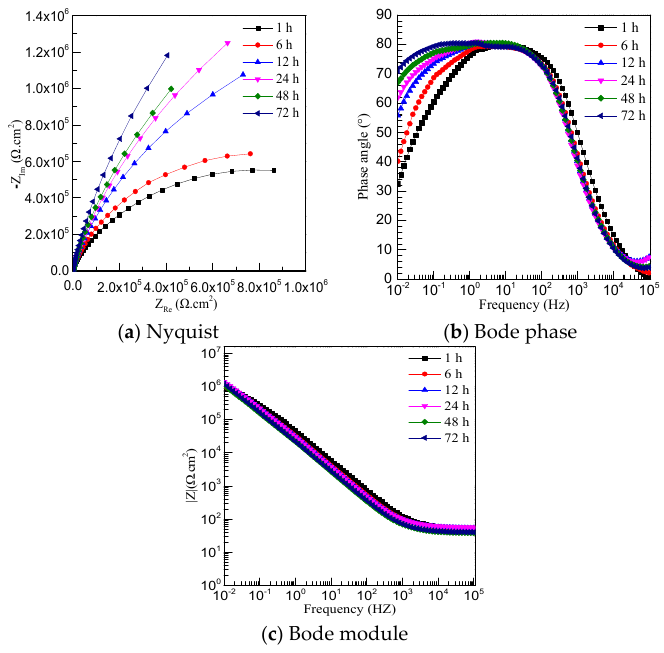
Figure 5. EIS (electrochemical impedance spectroscopy) spectra of BM measured at OCP (open circuit potential) after different immersion times in 1 M NaCl solution.